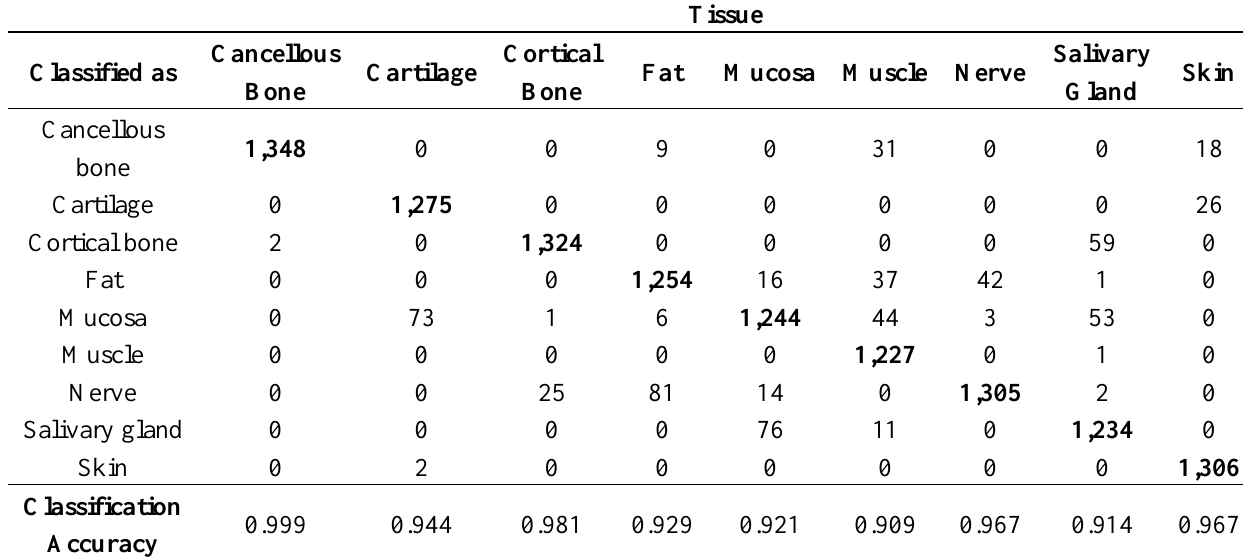
Table 2. Confusion matrix (total error 5.20%).